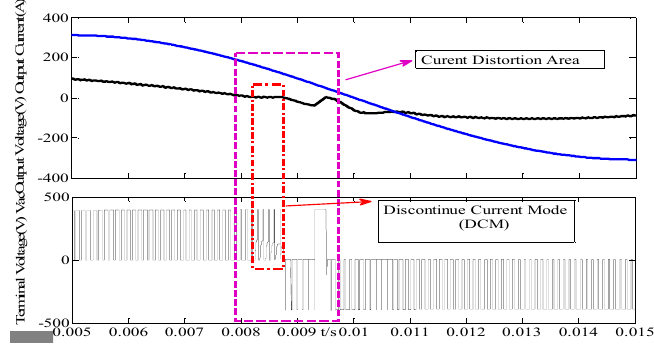
Figure 5. Terminal voltage during the distortion of current.